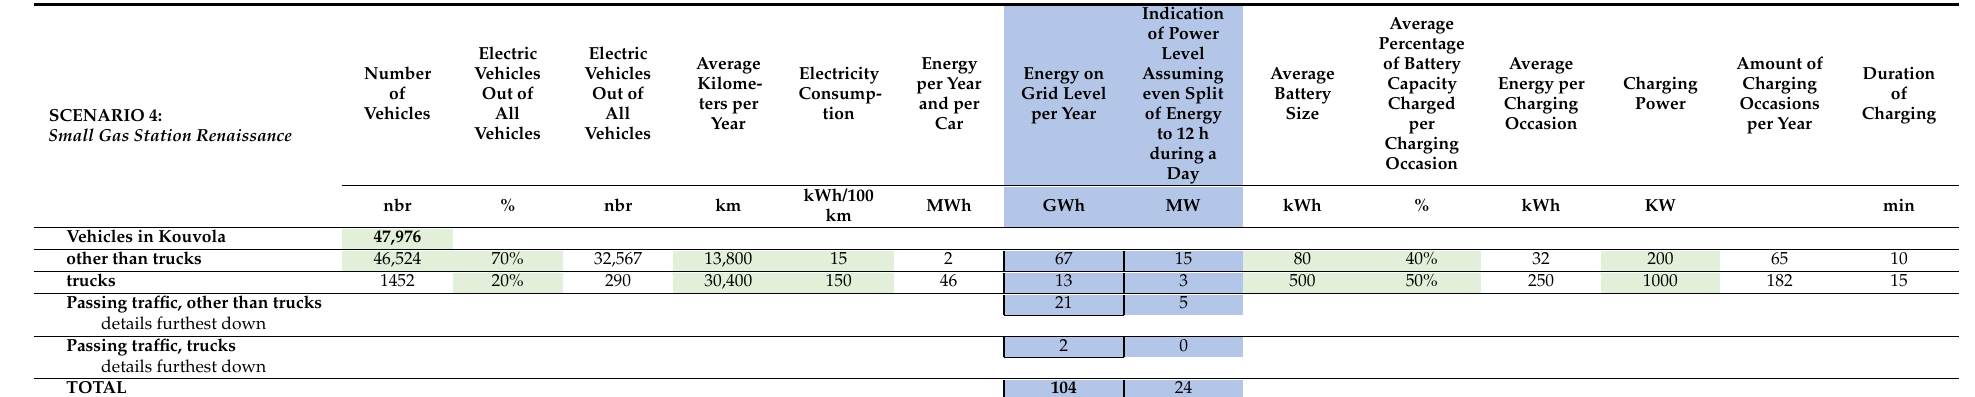
Table A10. Summary of Kouvola-based and passing traffic (including detailed quantification of the Kouvola-based traffic). Blue cells indicate results and green